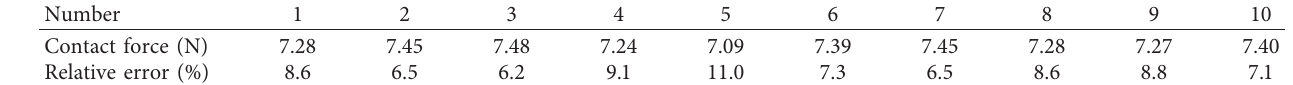
Table 1: Contact force data in traditional impedance control.